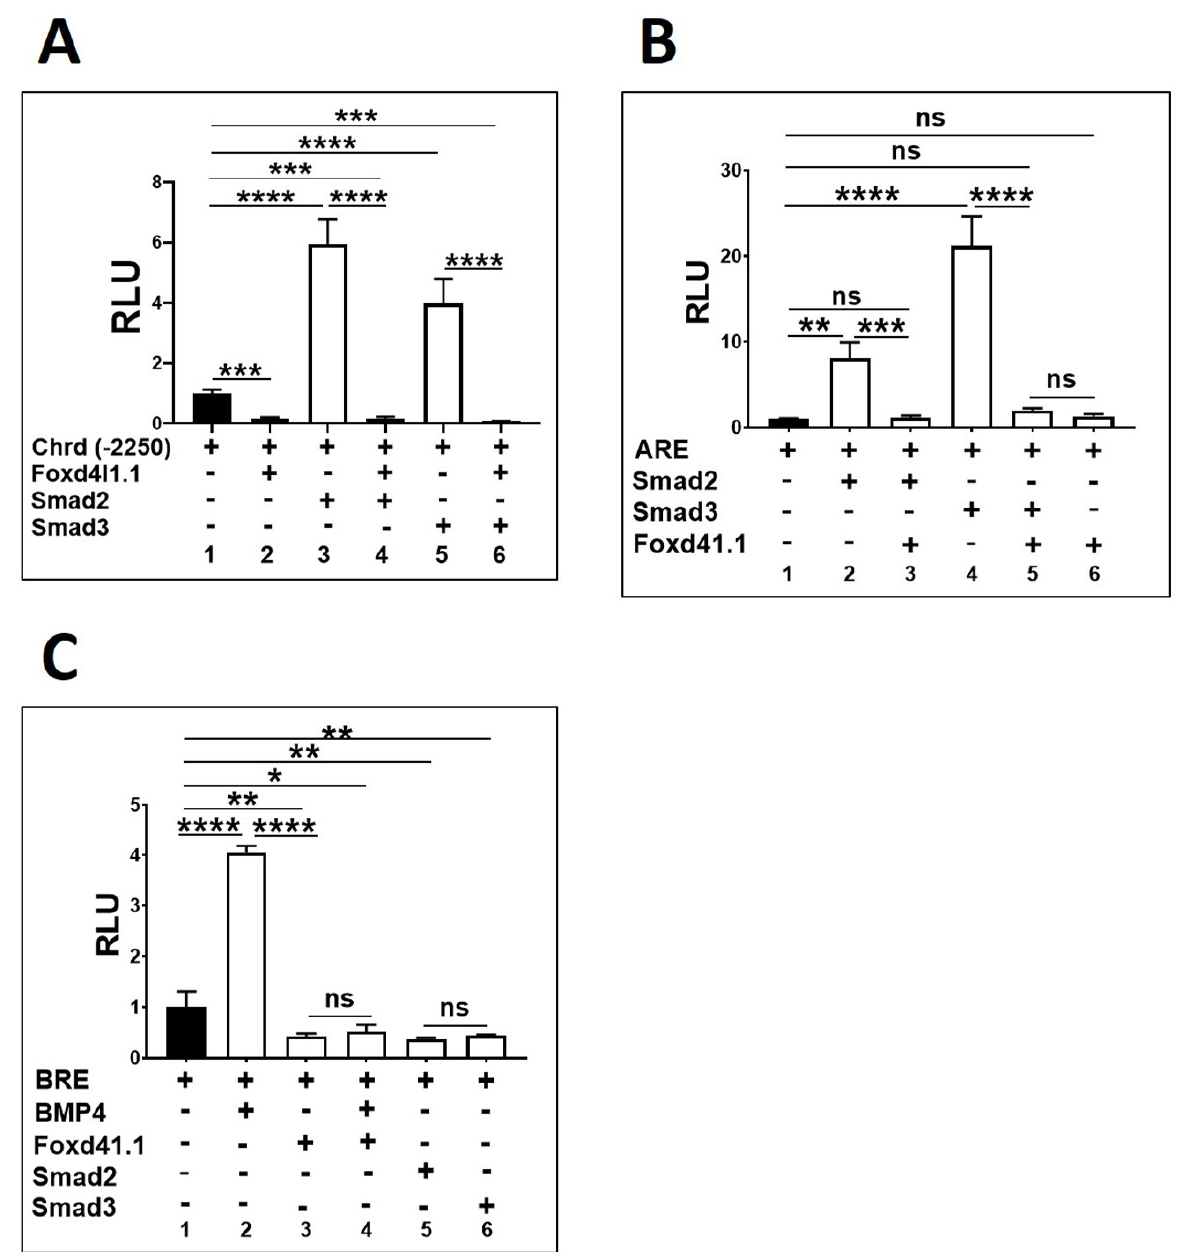
Figure 2. Ectopic presence of Foxd4l1.1 abolished chrd( − 2250) , ARE, and BRE mediated expression. Xenopus embryos were injected with chrd( − 2250) , ARE, and BRE (40 pg/embryo) with or without Foxd4l1.1, Smad2/3, or BMP4 mRNA (1 ng/embryo) at the one-cell stage and harvested at stage 11: ( A ) chrd( − 2250) reporter activities with or without Foxd4l1.1 or Smad2/3; ( B ) ARE reporter activities with or without Foxd4l1.1 or Smad2/3; ( C ) BRE reporter activities with or without BMP4, Foxd4l1.1, or Smad2/3. The y-axis represents relative light units (RLUs). * p ≤ 0.05, ** p ≤ 0.01, *** p ≤ 0.001, and **** p ≤ 0.0001, n.s. denotes non-significant values.